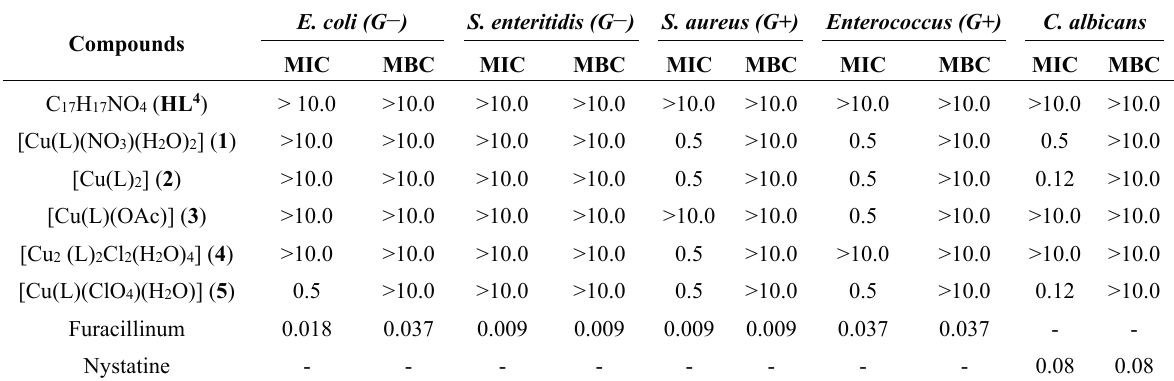
Table 5. Antibacterial activities of ligand HL and complexes 1 – 5 as MIC a /MBC b values